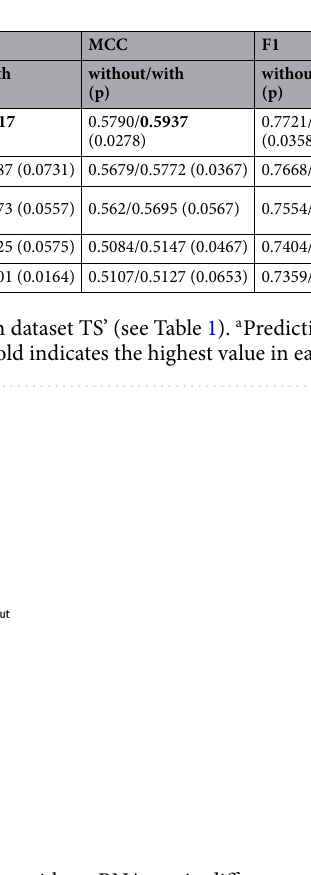
Figure 9. Accuracy (ACC) comparison between RNAfold with or without RNA-par in different ranges of RNA length. The dataset used was TS’ (See Table 1).